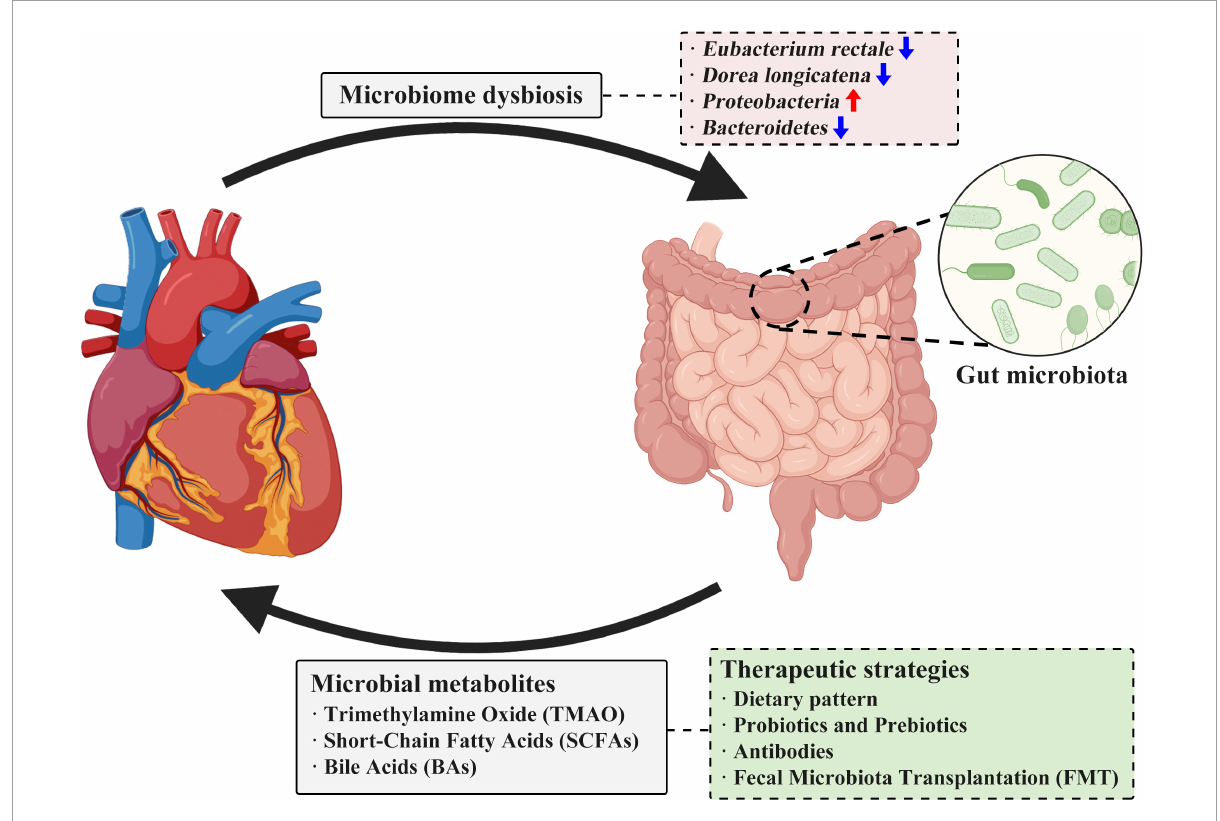
GRAPHICALABSTRACT Microbial metabolites that impact heart failure and correlated therapeutic